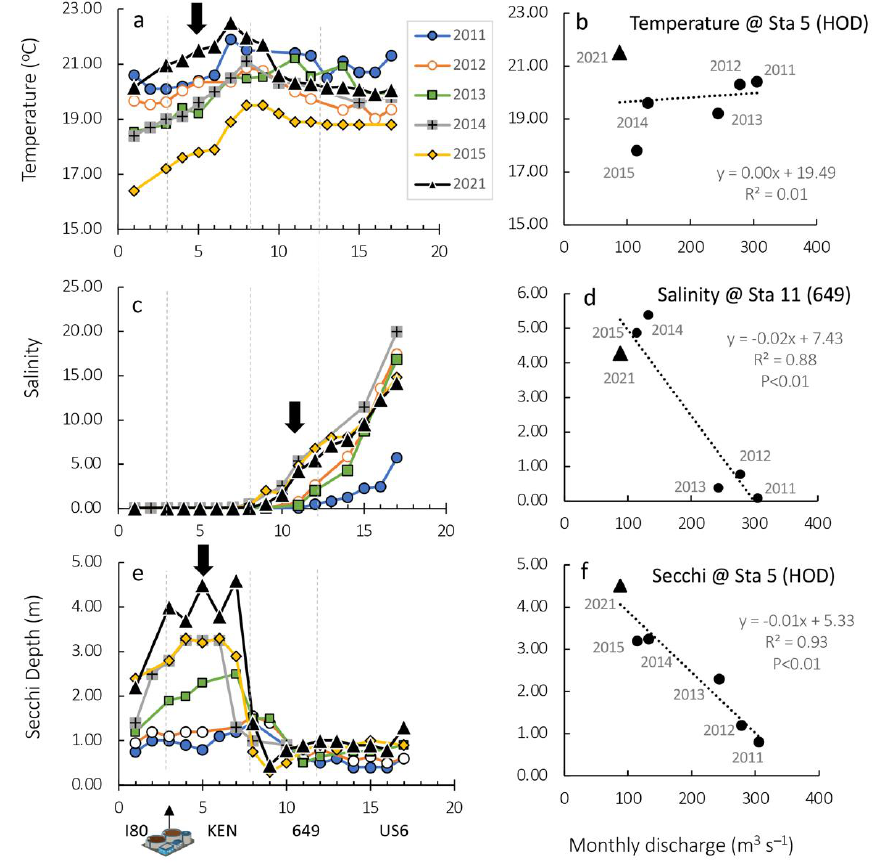
Figure 3. Transects of temperature (panel a ), salinity (panel c ) and Secchi depth (panel e ) for the six years of sampling undertaken in the Bay Delta during September/October. Sampling in 2021 was 5 months after full implementation of the upgraded WWTP. Vertical dashed lines separate the major segments of the river/estuary. The WWTP icon shows location of discharge. Relationships between temperature and flow at Station 5, salinity with flow at Station 11 and Secchi depth with flow at Station 5 are shown in (panels b , d , f ), respectively. Note the stations for which relationships with discharge are shown are highlighted by black arrows in (panels a , c , e ), and 2021 data in (panels b , d , f ) are highlighted by triangles.